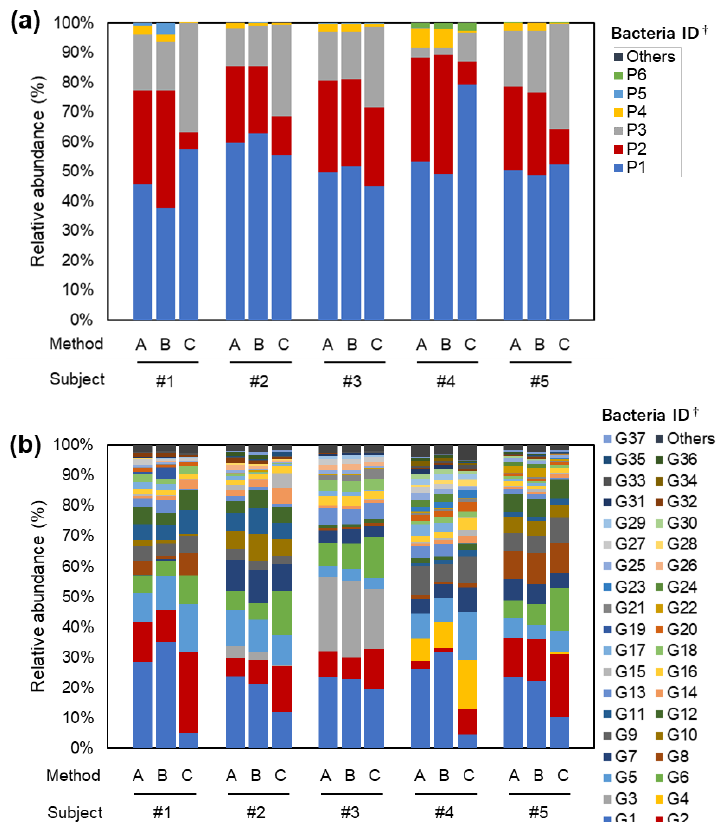
Figure 2. Research I: Fecal bacterial composition in five adult volunteers. Bacterial composition at the ( a ) phylum and ( b ) genus levels. Bacteria detected at a relative abundance of less than 1% were grouped together as Others. † See Table S1 or Table S5 for the bacterial taxonomy name corresponding to each ID.